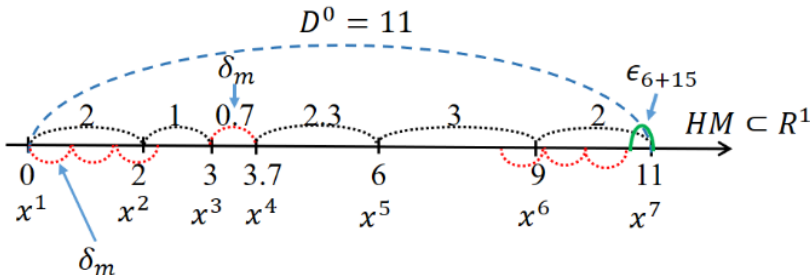
Figure 4. Convergence process in Example 1.